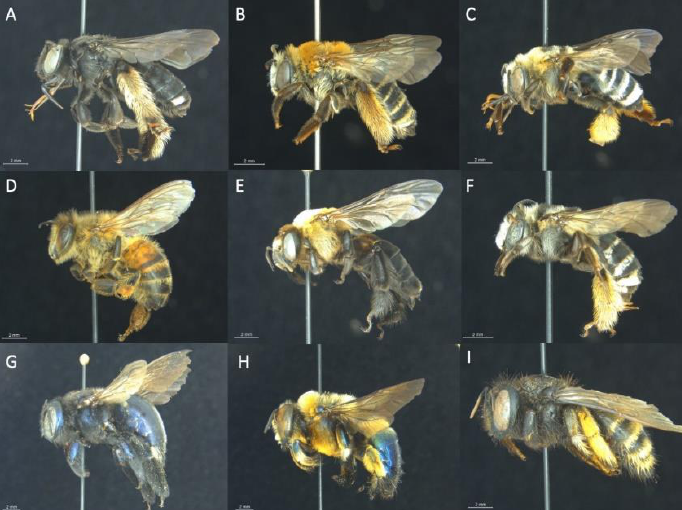
Figure 2. Some of the members of the family Apidae observed in cotton fields: ( A ) Melissodes (Melissodes) bimaculatus; ( B ) Melissodes (Melissodes) tepaneca; ( C ) Melissodes (Melissodes) communis; ( D ) Apis mellifera; ( E ) Ptilothrix bombiformis; ( F ) Florilegus condignus; ( G ) Xylocopa (Schonnherria) micans (female); ( H ) Xylocopa (Schonnherria) micans (male); ( I ) Xylocopa (Notoxylocopa) tabaniformis parkinsonae.